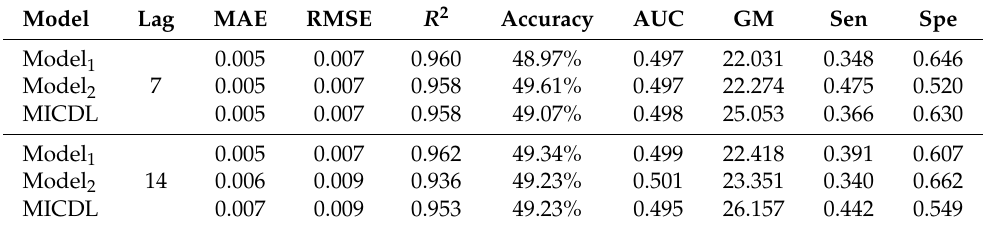
Table 6. Performance of the evaluated models for all XRP data.